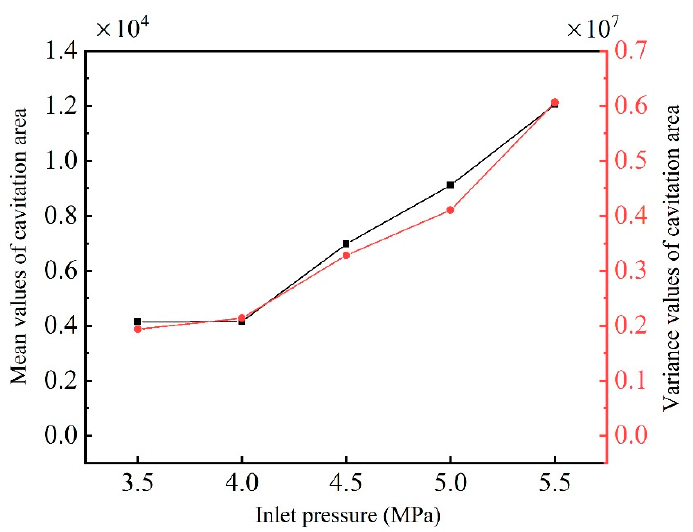
Figure 9. Mean and variance values of cavitation areas under increasing inlet pressures.